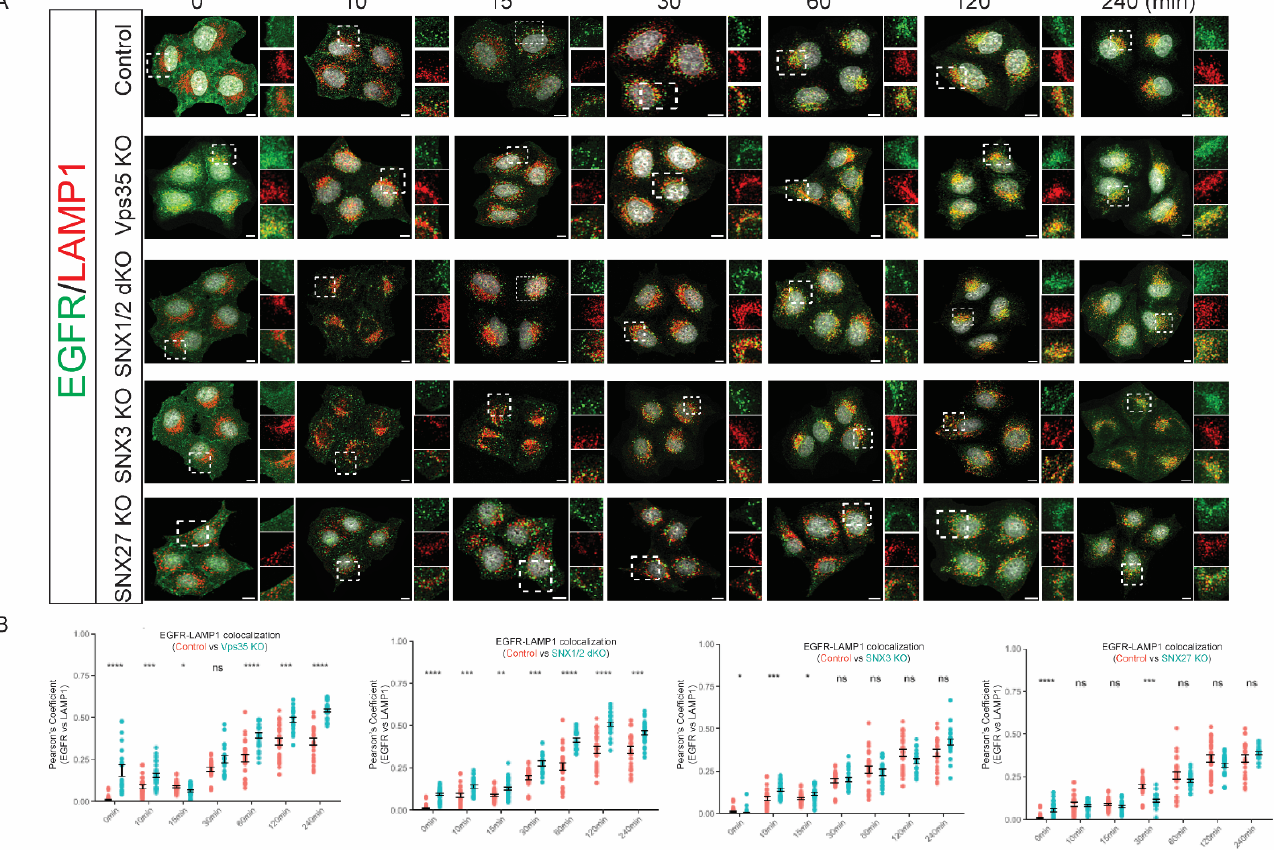
Figure 5. Retromer Vps35 and SNX1/2 depletion altered the kinetics of EGF-stimulated EGFR sorting to lysosomes. ( A ) Serum-starved HeLa control, Vps35 KO, SNX1/2 dKO, SNX3 KO, and SNX27 KO cells were treated with 100 ug/mL of EGF for the time points as indicated before fixation and immunolabeling with EGFR and LAMP1 antibodies. Images were captured on a Leica SP8 DMi8 confocal microscope using a 60× glycerol objective (Scale Bar, 10 µm). ( B ). Analysis of colocalization between EGFR and LAMP1 is presented by Pearson’s correlation coefficient. The value shows the difference between HeLa control cells and KO cells (means ± SEM). Two-tailed student’s t- test indicated the difference between HeLa control and KO cells at the time points as indicated, * p < 0.05; ** p < 0.01; *** p < 0.001; **** p < 0.0001.